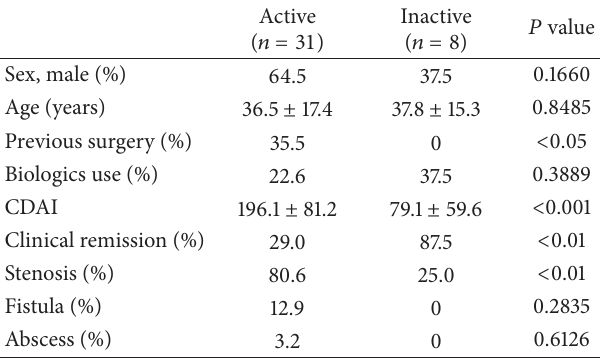
Table 1: Characteristics of the two study groups (univariate analy- sis).